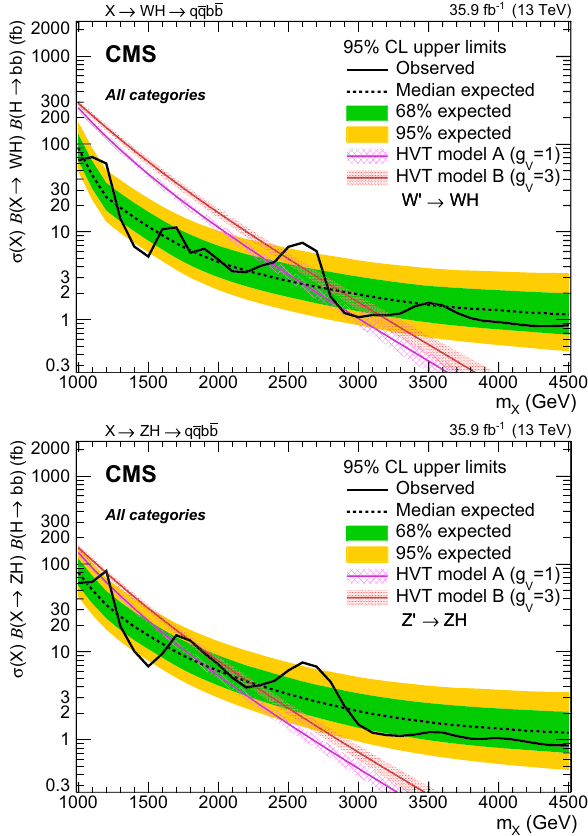
Fig. 5 Observed and expected 95% CL upper limits on the prod- uct σ( X ) B ( X → WH ) B ( H → bb ) (upper) and σ( X ) B ( X → ZH ) B ( H → bb ) (lower) as a function of the resonance mass for a single narrow spin-1 resonance, for the combination of the eight cat- egories, and including all statistical and systematic uncertainties. The inner green and outer yellow bands represent the ± 1 and ± 2 standard deviation uncertainties in the expected limit. The purple and red solid curves correspond to the cross sections predicted by the HVT model A and model B, respectively